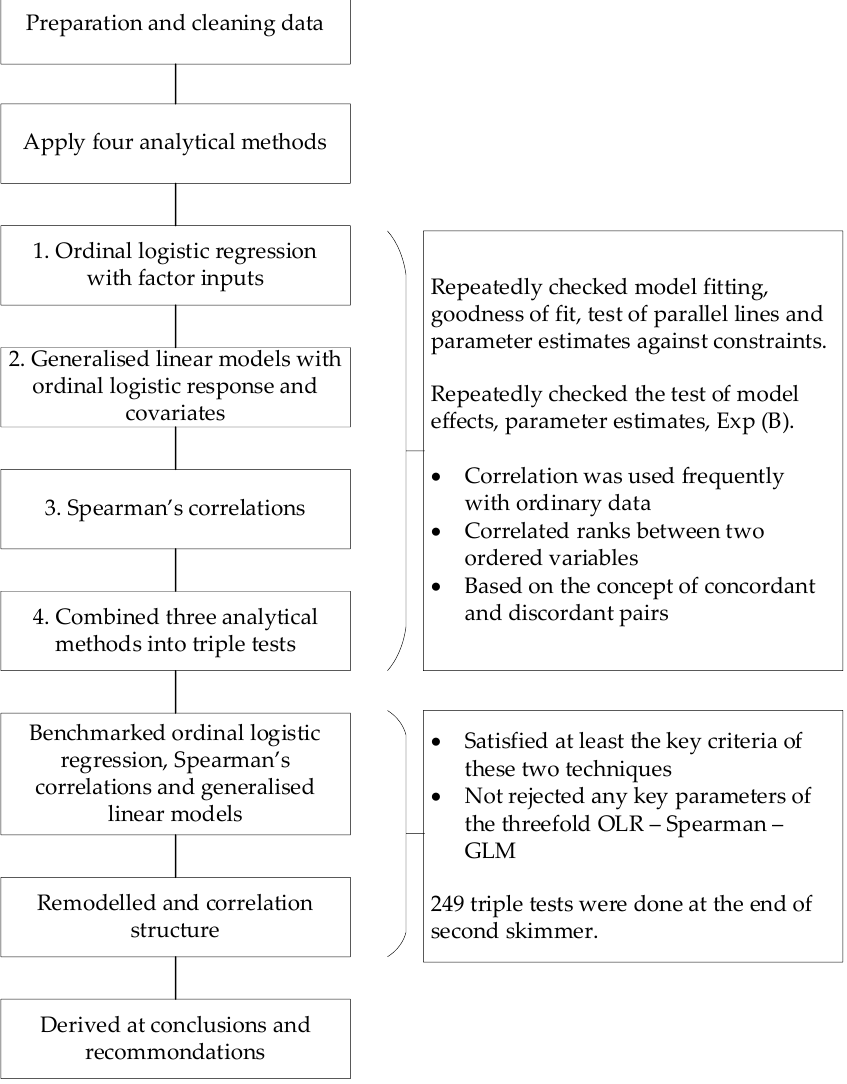
Figure 4. Methodology for data analysis.